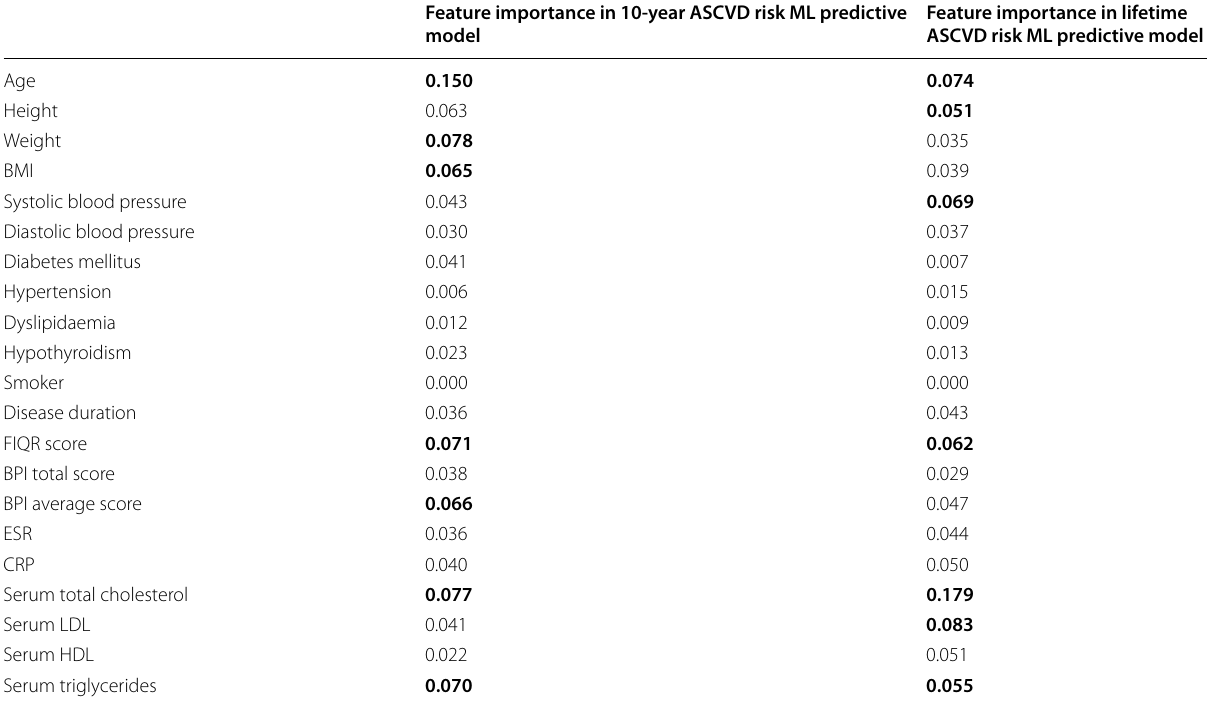
Feature importance is the degree of contribution in the random forest ML predictive model. Seven parameters of high feature importance are emboldened in each ML classifier model ML, Machine learning; ASCVD, atherosclerotic cardiovascular disease; BMI, body mass index; FIQR, revised fibromyalgia impact questionnaire; BPI, brief pain inventory; ESR, erythrocyte sedimentation rate; CRP, C-reactive protein; LDL, low-density lipoprotein; HDL, high-density